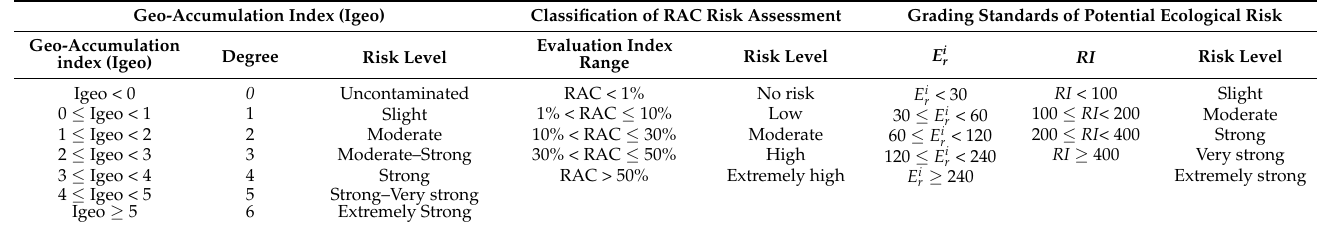
Table 2. Grading standards of potential ecological